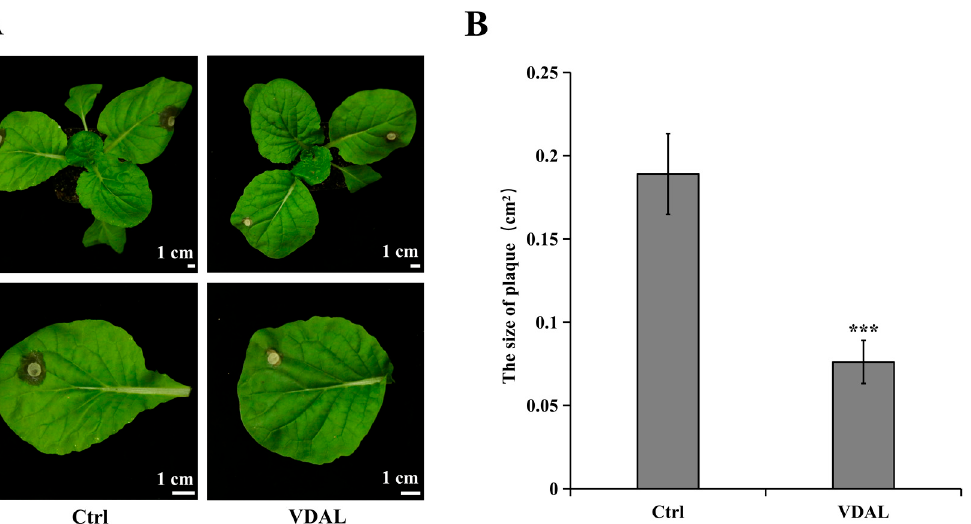
Figure 1. Effects of exogenous VDAL on S. sclerotiorum resistance in B. rapa . ( A ) Morphology and phenotype of representative B. rapa seedlings with water or VDAL treatment followed by S. sclerotiorum inoculation for one day. ( B ) Histogram of plaque area from leaves inoculated with S. sclerotiorum under water or VDAL treatment. Eighteen independent replicates were performed. Student’s t -test (*** p < 0.001) was used to estimate significant effects.